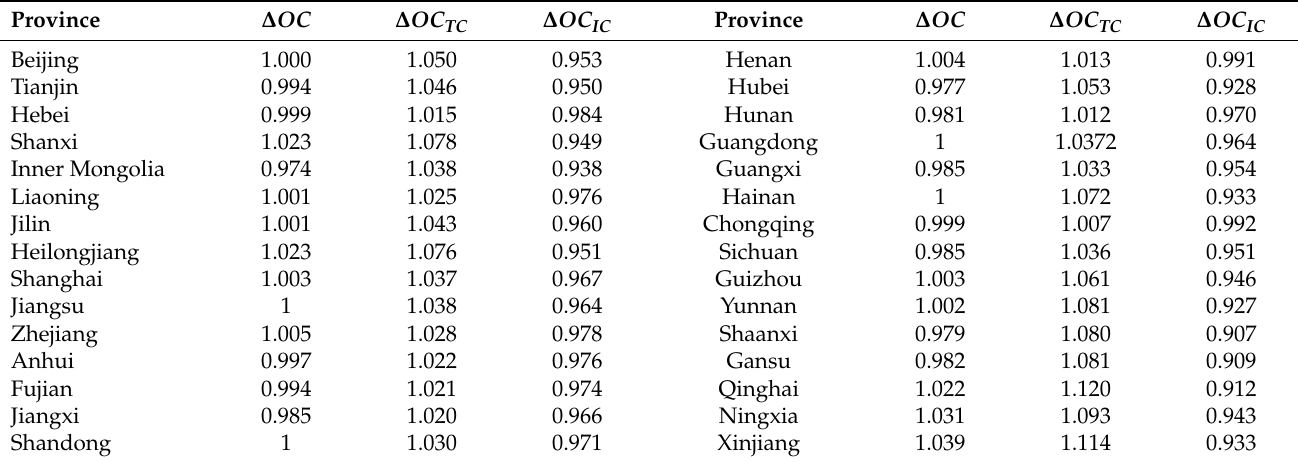
Table 2. Change in opportunity cost and its decomposition for provinces during